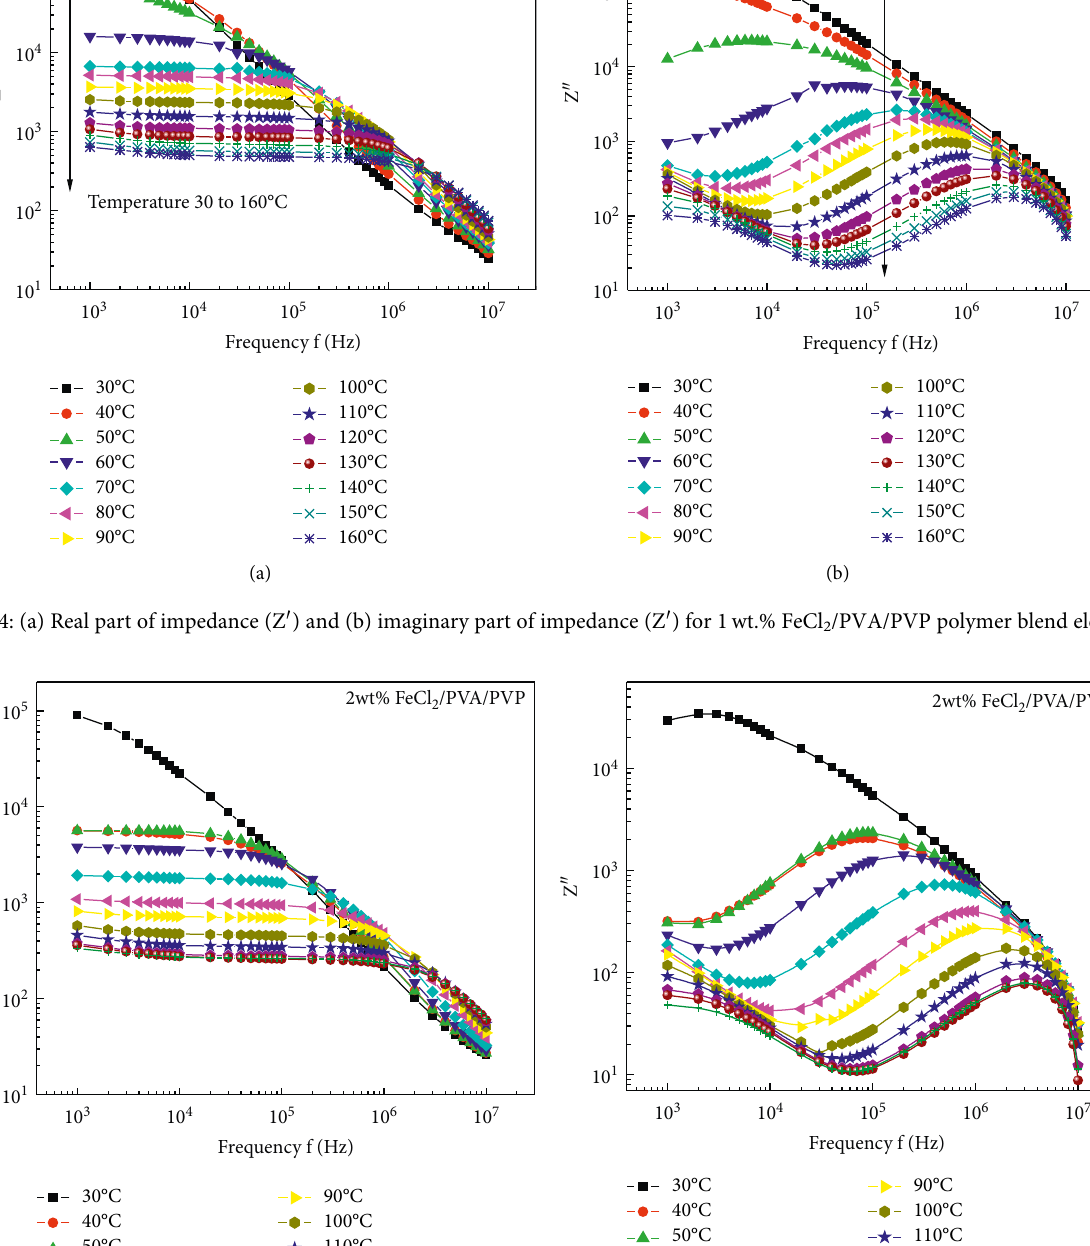
2 /PVA/PVP polymer blend PVA-50 wt.% PVP blend and doped with 0.5, 1, and 2 wt.% FeCl ) as a function . The AC conductivity ( σ ) is found to be temperature ac 2 ac and frequency-dependent. AC conductivity behaviors of all